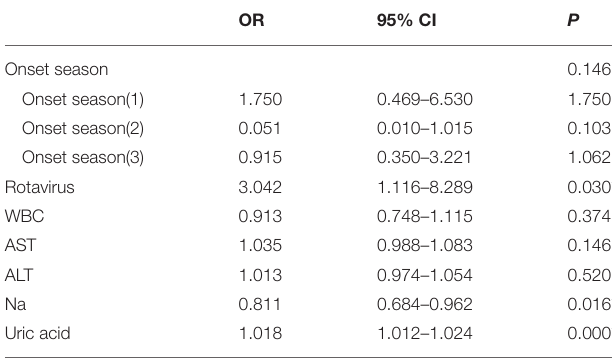
TABLE 2 | Univariate analysis between the CwG group and the AGE group. TABLE 3 | Multivariate logistic analysis between the CwG group and the AGE group.